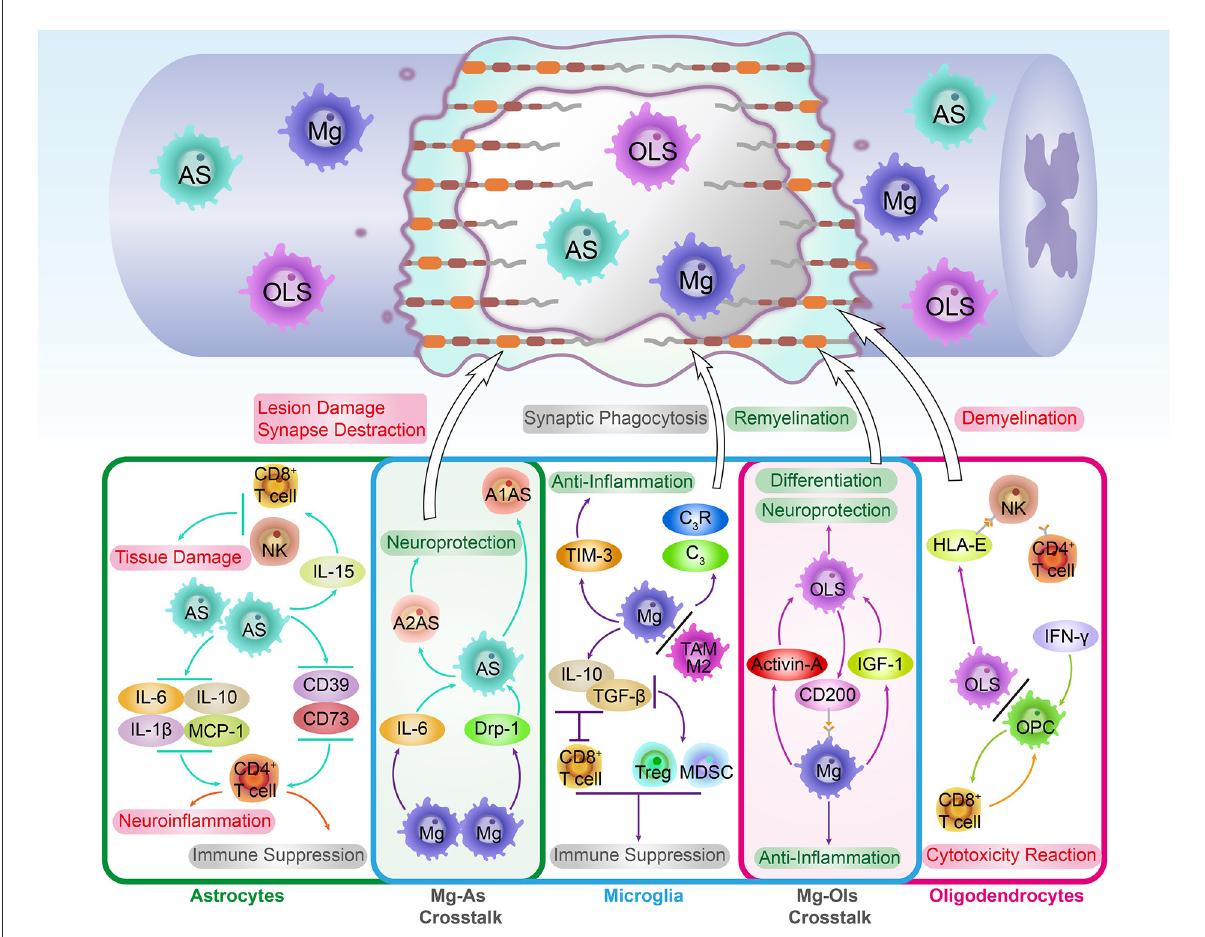
FIGURE1 The immune roles and cross-talk of innate glial cells in the spinal cord. As the co-founder of CNS, the spinal cord’s innate glial cells, including astrocytes, microglia, and oligodendrocytes, are essential for immune landscape establishment during SCI pathological repair process. From the SCI recovery point of view, these glial-related immune responses played mixed roles in the key steps of SCI pathological repair. To illustrate, by expressing pro-inflammatory and anti-inflammatory cytokines, glial cells modulate lymphocyte-induced neuroimmune functions. These functions could be beneficial and neuroprotective, which promote remyelination, axon regeneration, and glial differentiation. Instead, they also could be detrimental to SCI recovery, which aggravates tissue damage, cytotoxicity reaction, and demyelination. In addition, glial cells are still able to orchestrate the complement system activation and lymphocyte phenotypes transformation. Remarkably, the crosstalk among innate glial cells not only strengthens the communication between the CNS and immune system but supports the exploration of novel targets for SCI treatment. An important example of crosstalk is microglia-mediated astrocyte phenotype transformation, which induces the neuroprotective A2 phenotype astrocyte